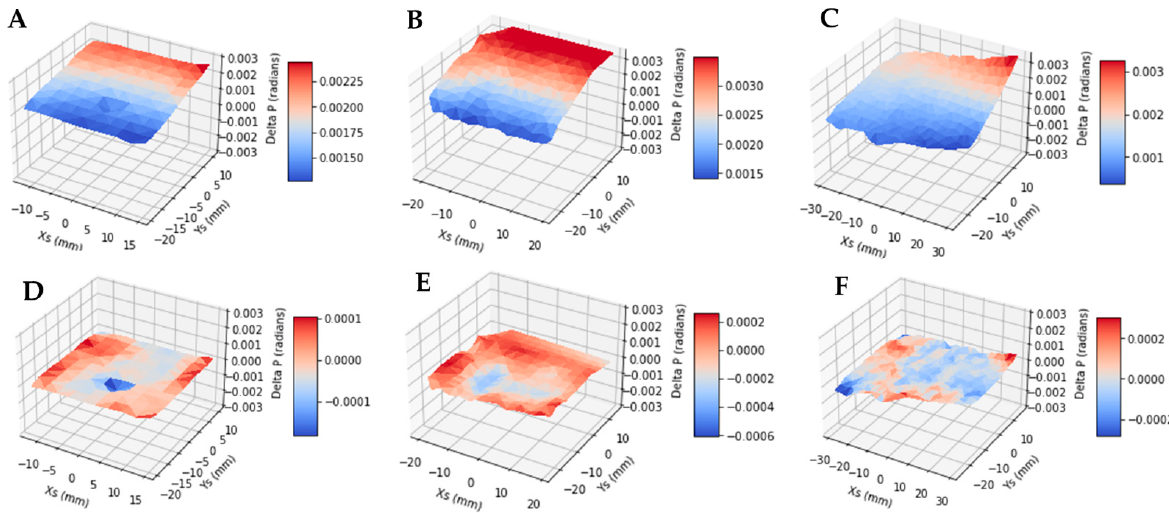
Figure 4. Surface plots of the measured in-plane deviation angles of the marker trajectories relative to the ideal horizontal direction, as a function of the marker position in the sample coordinate system. Plot ( A ) is from a scan of the typical speed of 0.0272 mm/s and range of 24 mm, ( B ) a scan of half the typical speed and range, and ( C ) a scan of twice the typical speed and range. Plots ( D – F ) are the residual deviation angles after subtracting the fit of the model of the scan geometry described by Equation (5) in Methods. The RMS of the residual deviation angles is <7.5% of the RMS of the original deviation angles. This indicates that the parametric model of Equation (5) adequately approximates the sample stage movement.